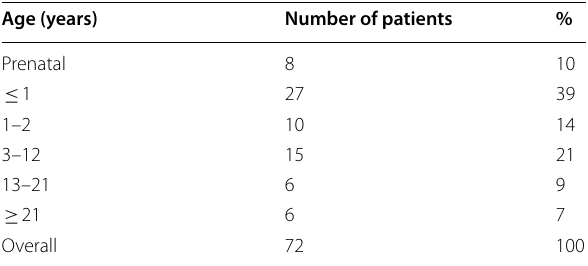
Table 2 Age of patients studied here with molecular and